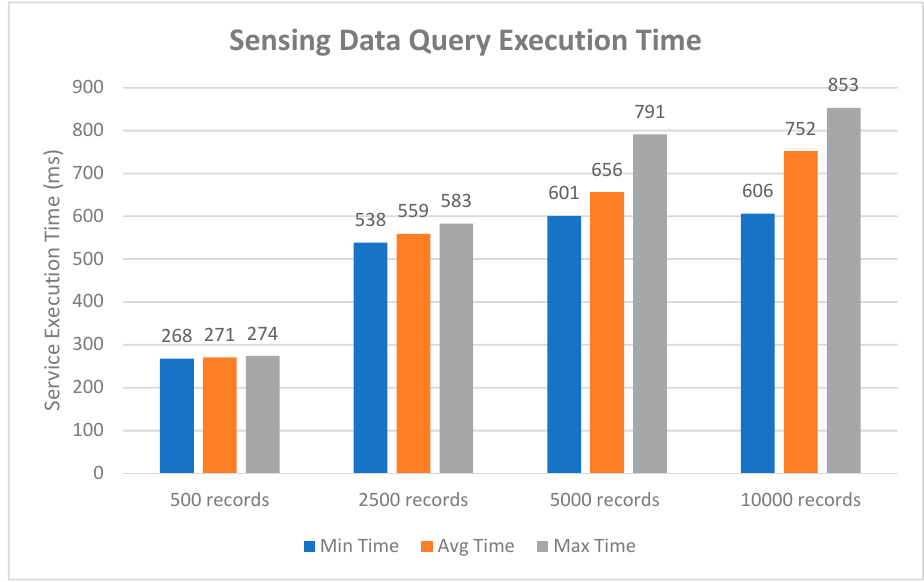
Figure 17. Performance analysis graph of the sensing data query.